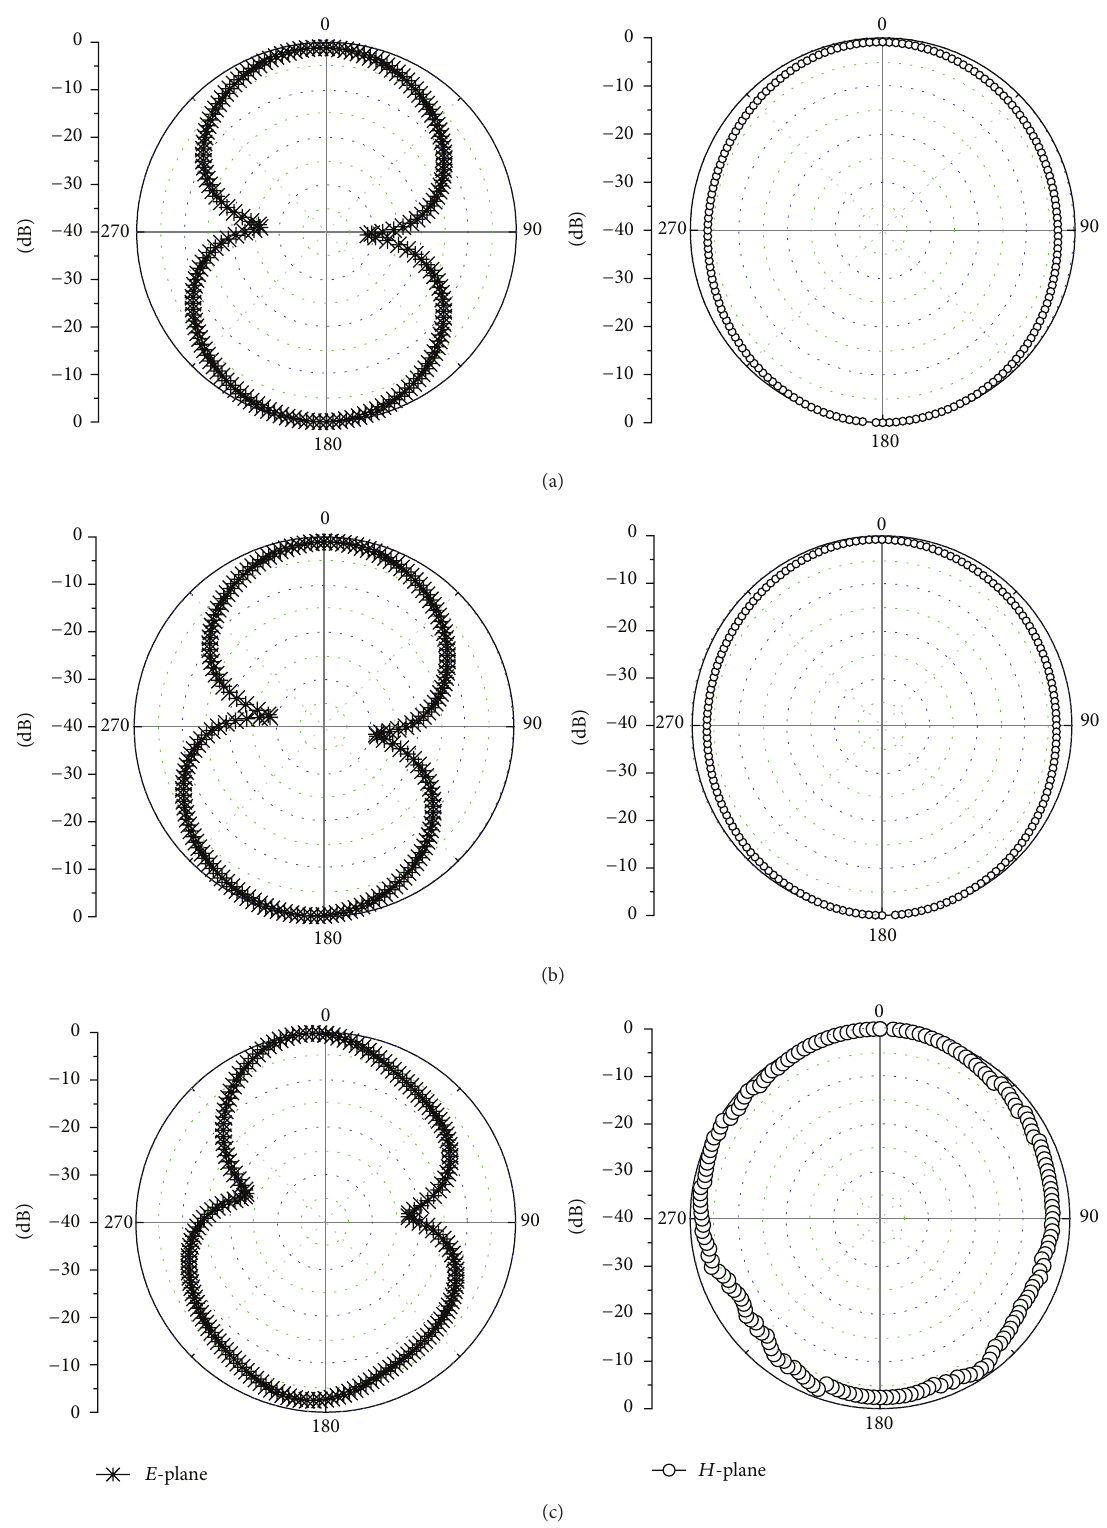
Figure 11: The measured radiation patterns in the H -planes and the E -planes (a) at 4.5 GHz, (b) at 6.0GHz, and (c) at 8.9